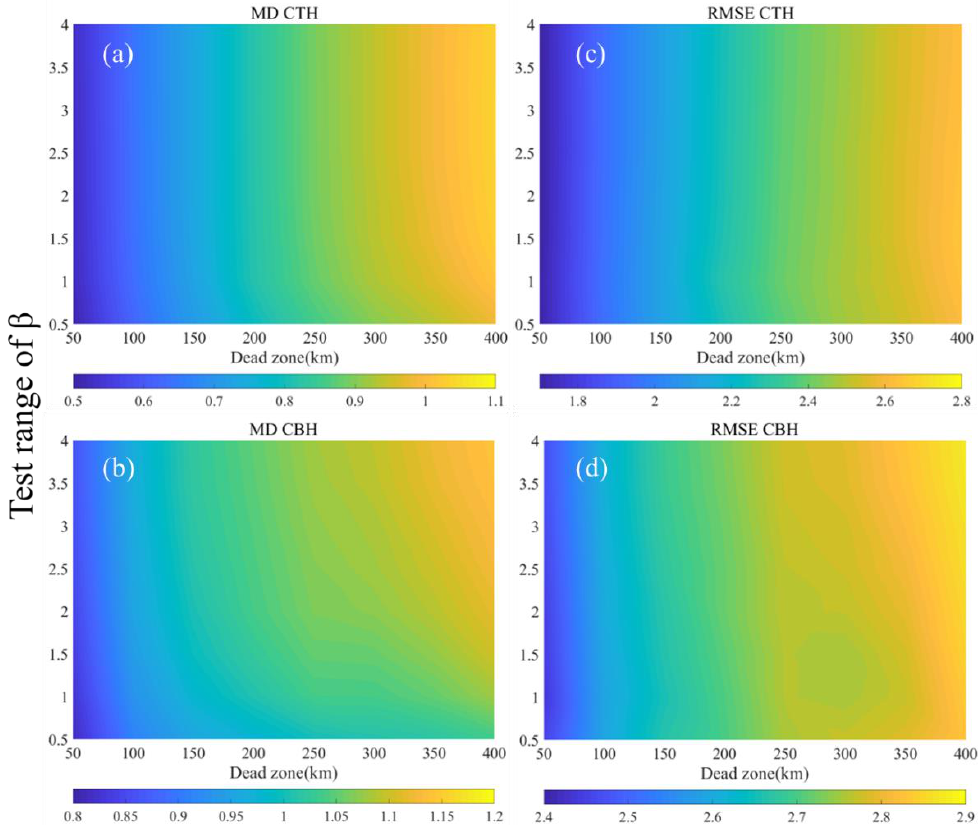
Figure 3. Mean deviation (MD) ( a , b ) and root mean square error (RMSE) ( c , d ) of CTH and CBH between the original profiles and the reconstructed profiles, changing with β and dead zone.